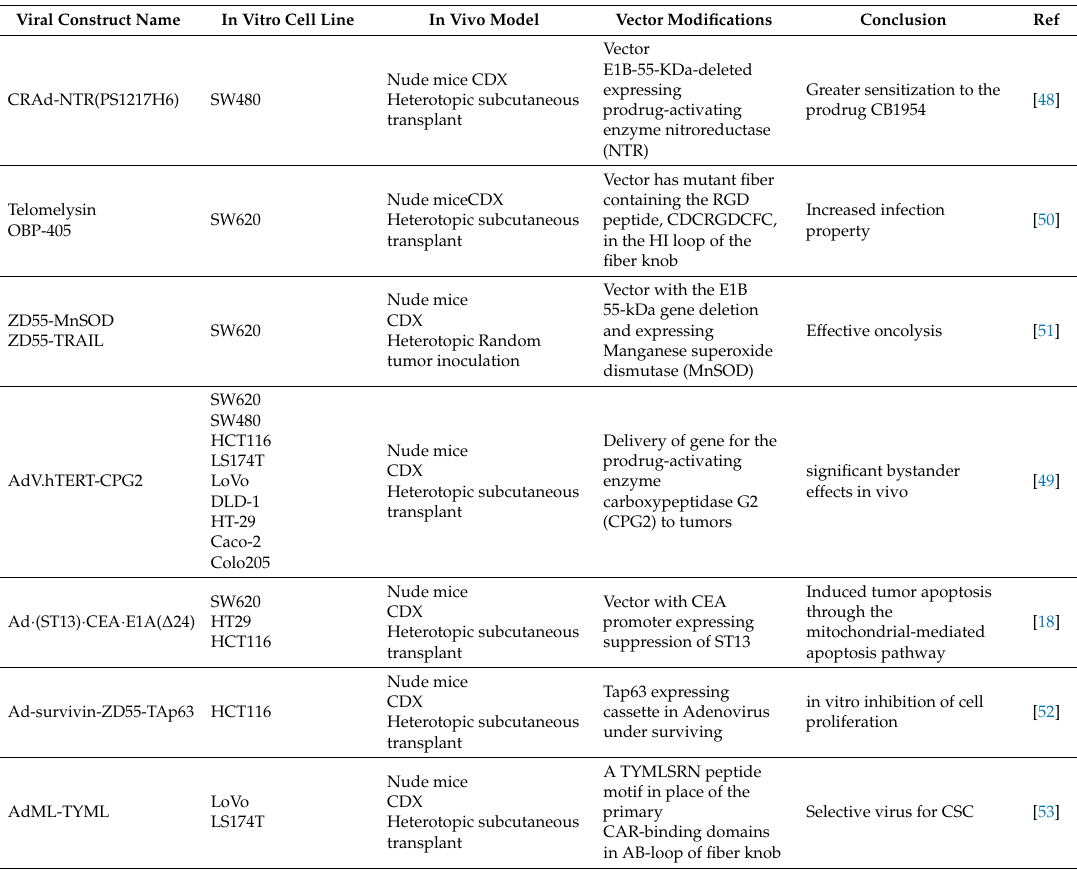
Table 7. Preclinical research in colorectal